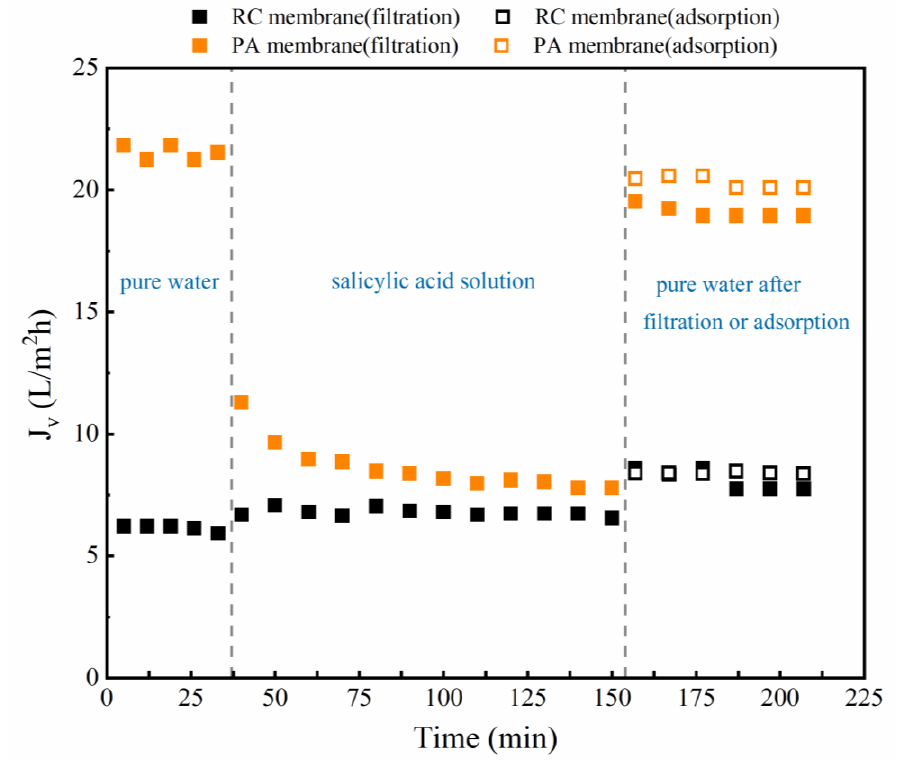
Figure 6. The evolution of the flux of SA during the two membrane filtration processes and water before and after the filtration and adsorption experiments over time. In the last column, the solid point represents the pure water flux after filtration, while the hollow point represents the pure water flux after soaking in phenolic acid solution. Experimental conditions: 2 bar; feed concentration = 10 mM and 25 ± 2 °C.